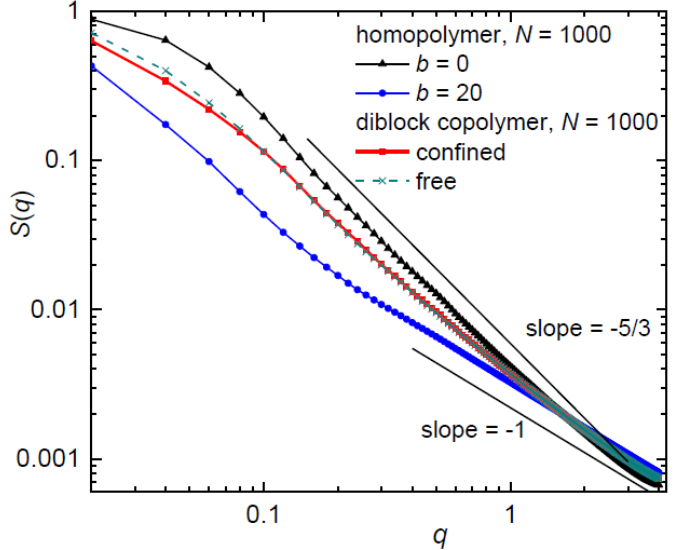
Figure 8. Structure factor for a diblock copolymer and respective flexible and semi-flexible homopolymer in a weakly confining array of d p = 1.9, S p = 12. A free unconfined diblock copolymer is also shown for comparison. The lines with the slopes − 5/3 and − 1 represent theoretical predictions for a flexible and semi-flexible/stiff homopolymer chain, respectively.